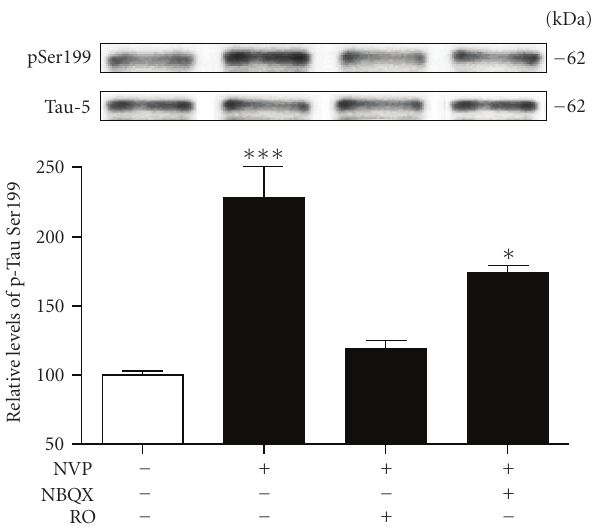
Figure 4: NR2B-containing receptors play a role in Tau phospho- rylation induced by NVP. Phosphorylated Tau levels at Ser199 were estimated by Western blotting on cell extracts obtained from acute hippocampal slices treated with 50nM NVP for 2 hours alone or in combination with 10 μ M NBQX and 10 μ M RO25-6981. The data, expressed relative to total Tau (i.e., Tau-5) levels, are means ± SEM of 3 measurements per cell extract obtained from 4 di ff erent rats. Statistical analysis was performed by one-way ANOVA followed by Neuman-Keuls’ post hoc test. ∗ P < . 05, ∗∗∗ P < . 001, drug-treated versus